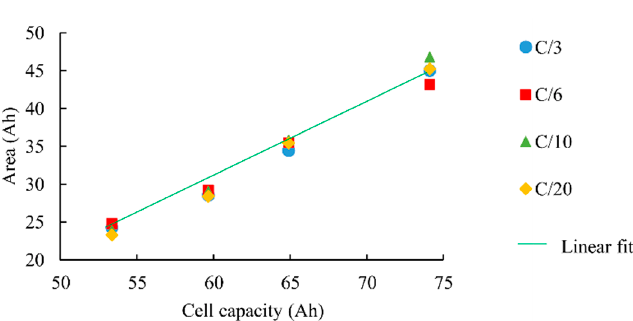
Figure 10. Measured area function of cell capacity for various charging currents and with pause before peak 2 (100% DoD-25 °C). peak 2 (100% DoD-25 ◦